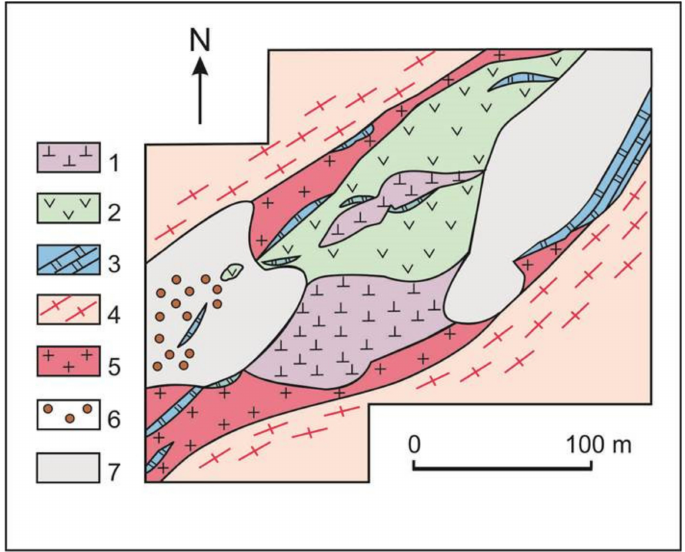
Figure 4. Geological map of Turpan peridotite. 1 = harzburgite and enstatitite; 2 = amphibolite, garnet amphibolite; 3 = calcite-dolomite marble; 4 = gneisss and gneissic granite; 5 = gneissic granite and pegmatite; 6 = scattered geyserite; 7 = quaternary